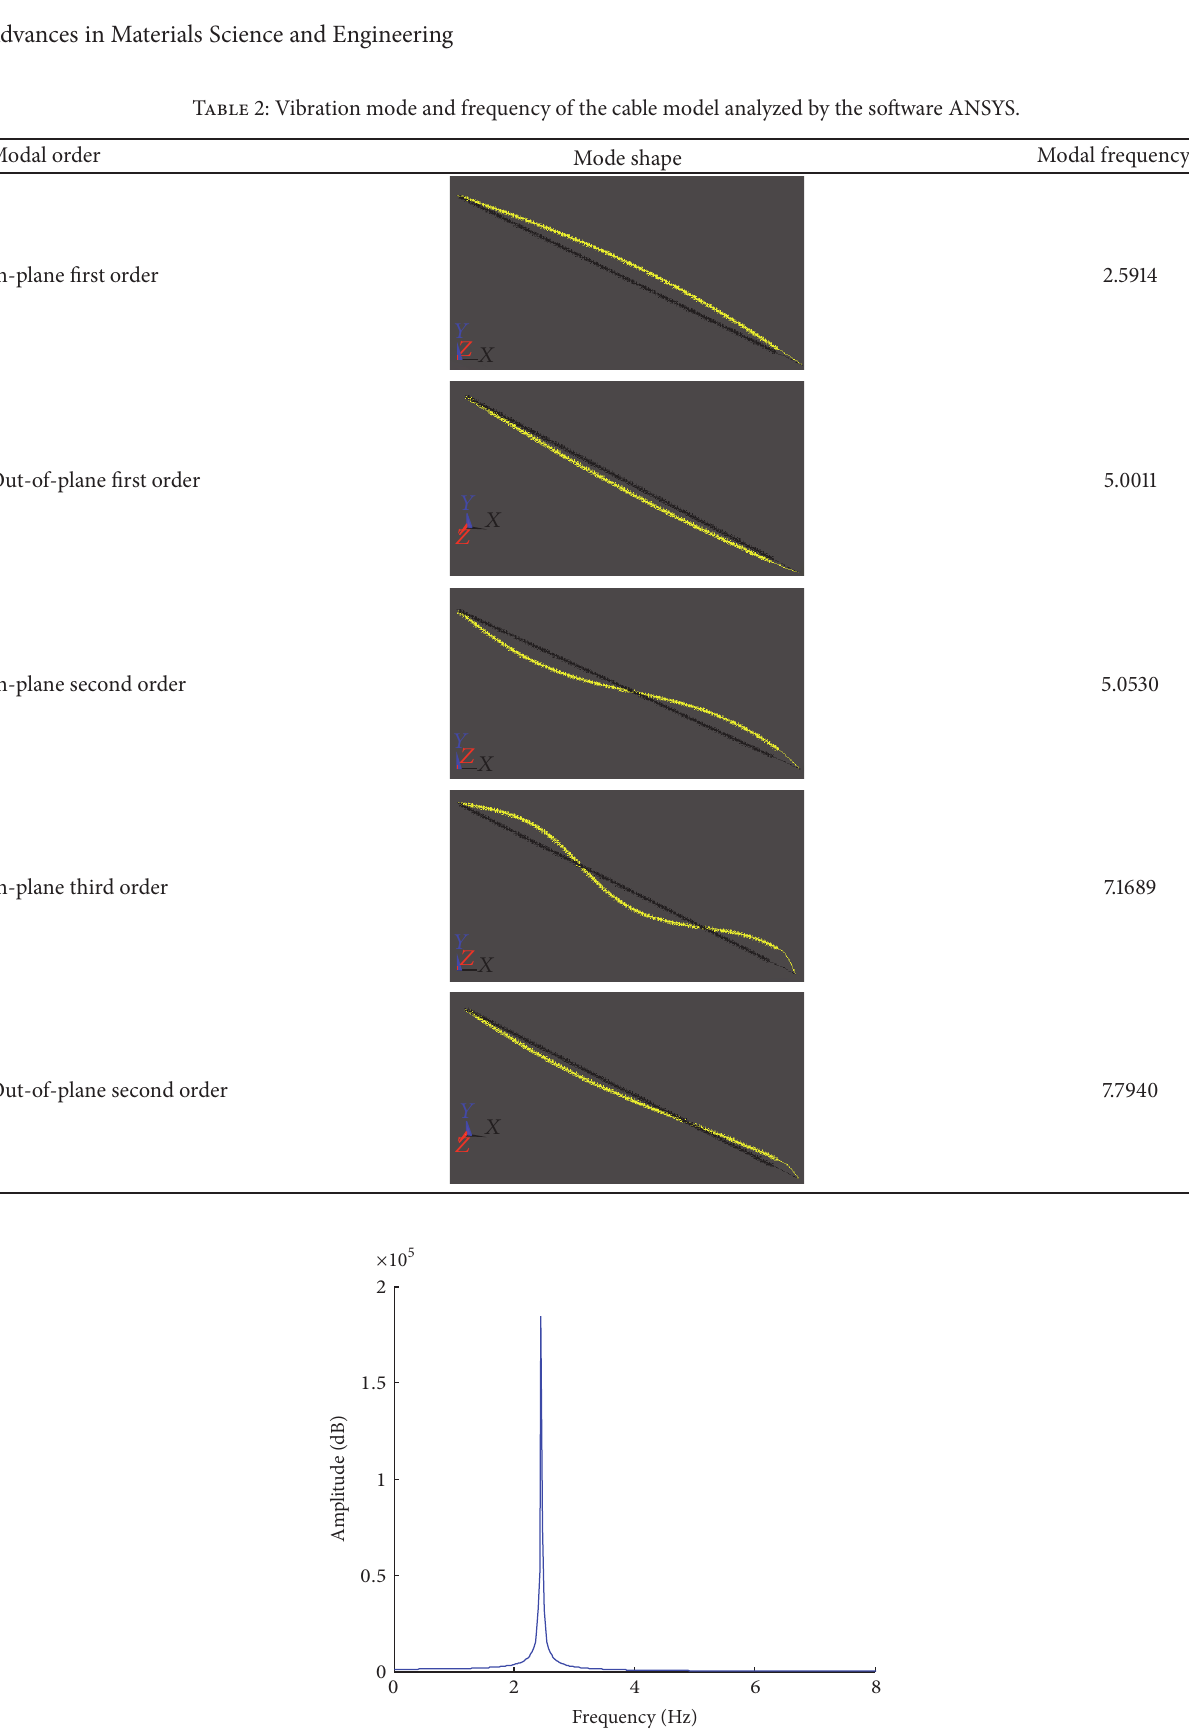
Figure 14: Spectral curve of cable model free